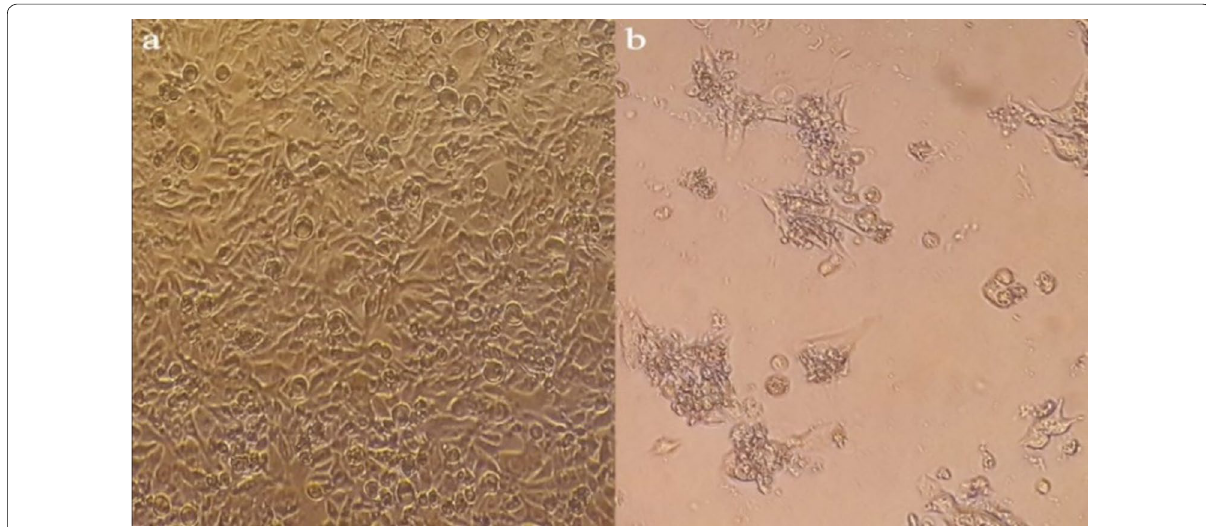
Fig. 2 The morphology of human prostate cancer (LNCap cells) a before treatment with hydroalcoholic extract of L. usitatissimum , b after treatment with hydroalcoholic extract of L. usitatissimum (after 48 h)